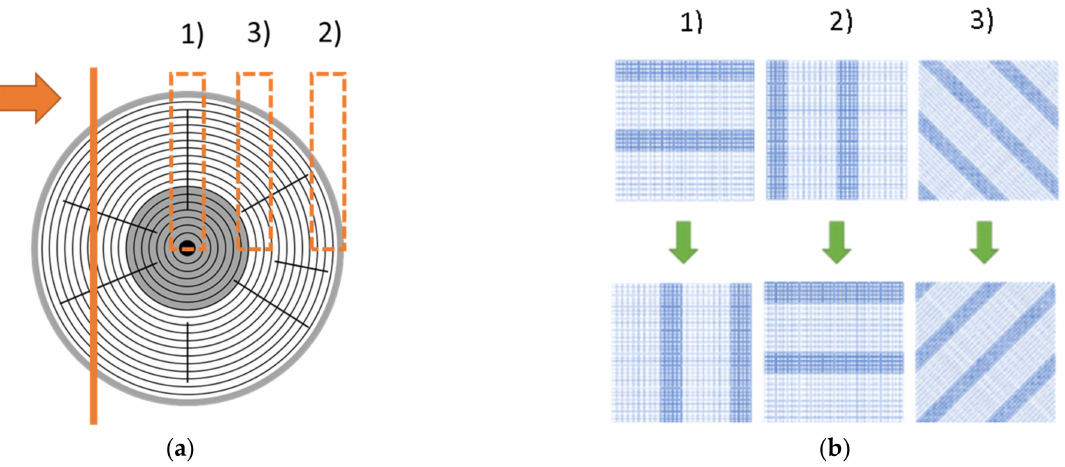
Figure 7. Schematic representation of the position of the cutting plane ( a ) and the resulting production- related variations of the EW and LW positions in height direction of the wood particle ( b